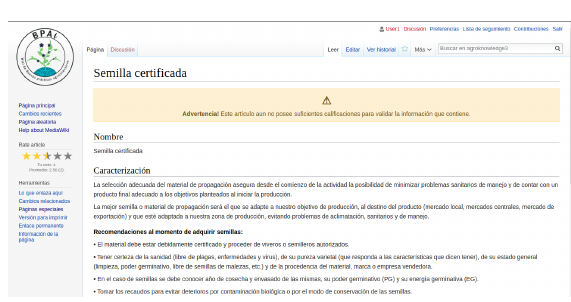
Figure 4. An extension API for the BPAi wiki. Screen